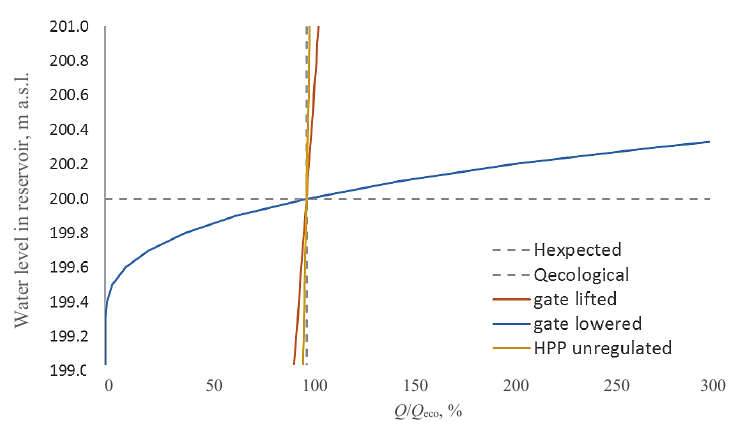
Fig. 4. Comparison of ecological flow discharge facilities – flow difference due to the reservoir water level